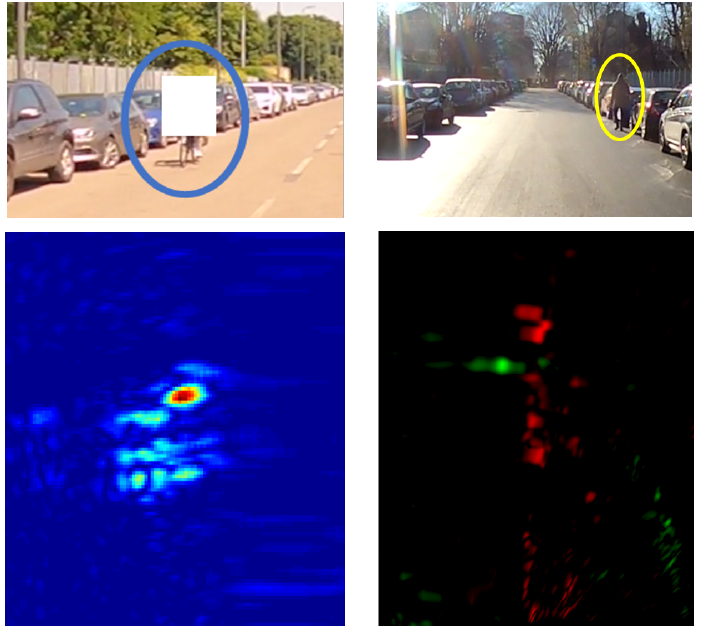
Figure 15. ( top left ) Optical image of a cyclist. ( top right ) A walking pedestrian on the roadway. ( bottom left ) SAR amplitude image of the cyclist. The bright spots are micro-Doppler variations associated with different parts of the bicycle. ( bottom right ) RGB composite of the static scenario (in red) and the moving pedestrian (in